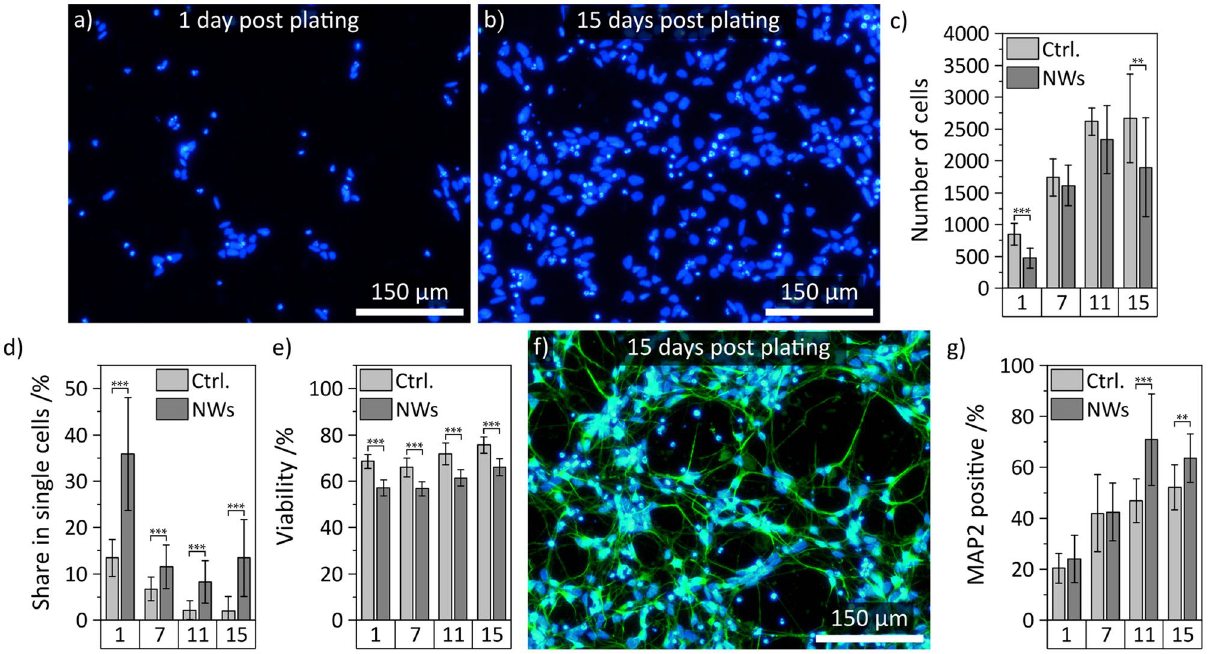
Figure 3. Analysis of cell number, cell viability and neuronal differentiation on NWs compared to planar control (1, 7, 11, and 15 days post plating). ( a ) and ( b ) Exemplary widefield microscopy images of cells 1 and 15 days post plating on NW substrates. The nuclei are labeled in blue using Hoechst 33342. ( c ) Quantification of the cell numbers per image 1, 7, 11, and 15 days after plating compared to control. ( d ) Share of cells not associated with a cell cluster of three or more cells. ( e ) Cell viability 1, 7, 11, and 15 days after plating compared to control. ( f ) Exemplary immunofluorescence image of human iPSC-derived neurons 15 days after plating. The neurons are labeled with MAP2 (green) and counterstained with Hoechst (blue). ( g ) Share in MAP2 positive cells 1, 7, 11, and 15 days after plating compared to control. All error bars are standard deviations (SDs). Table S1 of the supporting